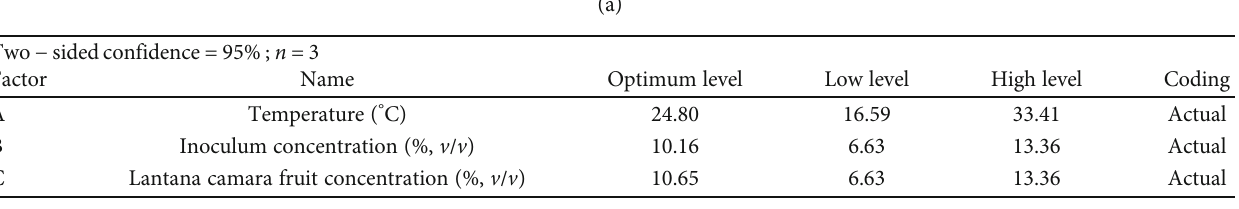
Table 8: Con fi rmation report to validate the combination of fermentation parameters.